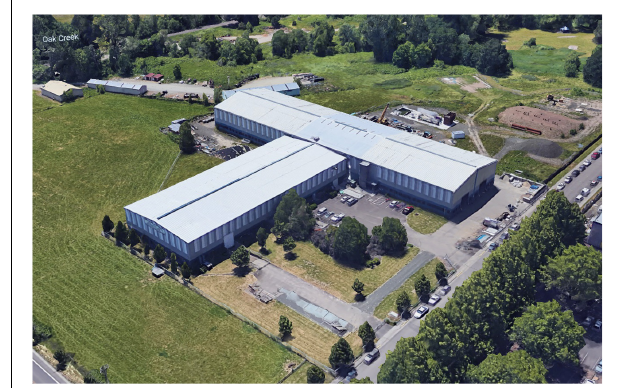
FIGURE 1 | Aerial view of O.H. Hinsdale Wave Research Laboratory. Image: Google